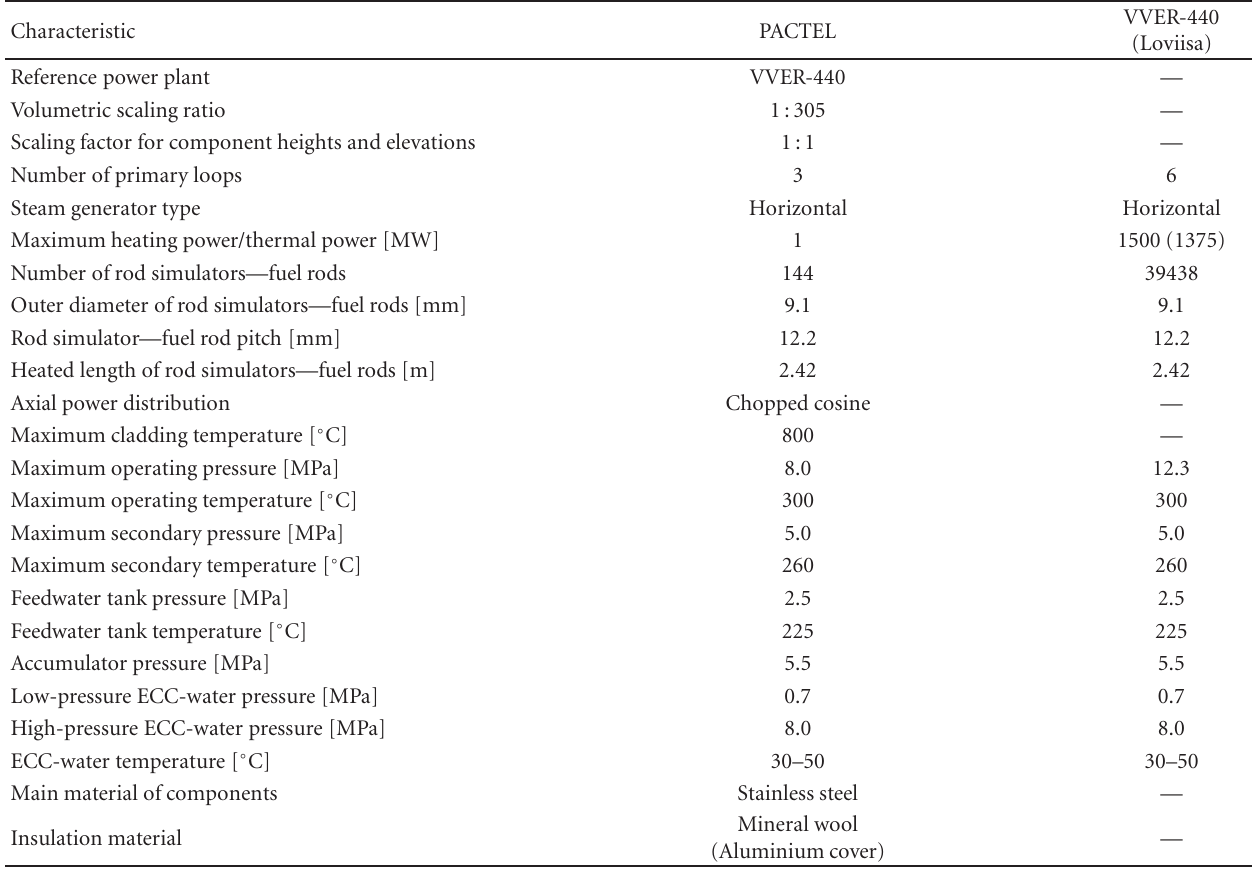
Table 1: PACTEL facility characteristics and comparative reference reactor